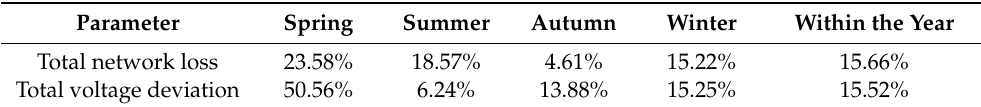
Table 1. The percentage of decrease in total network loss and voltage deviation after dispatching of ES and EV.